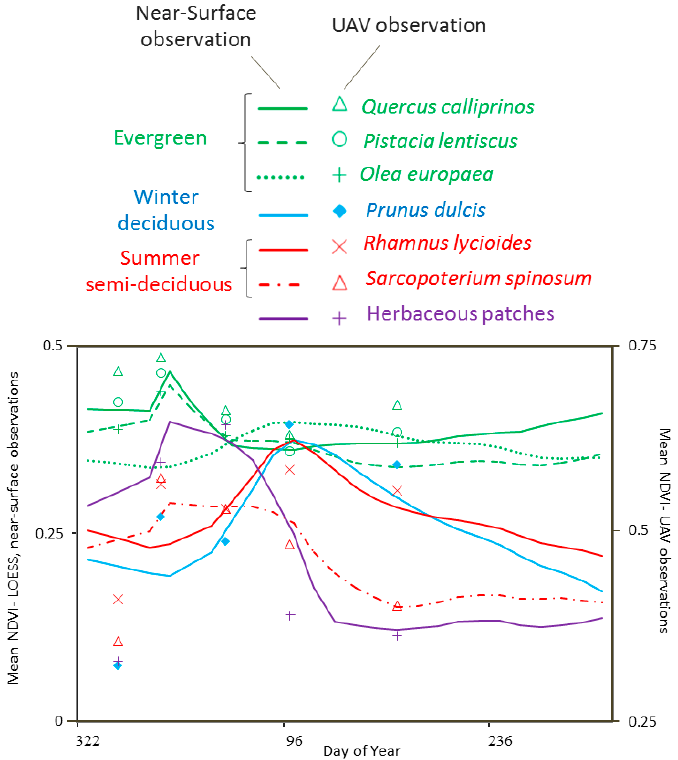
Figure 12. Mean NDVI time series of the near-surface and UAV observations for seven species that were classified in the Mata (M) site. The time series presents two following periods—LOESS of the preliminary near-surface observations (26 dates, 18 November 2015 to 2 November 2016), and five UAV imagery acquisition dates during the following year (Table 3). The sample size of each presented species is displayed in Supplementary Table S3. Pinus halepensis is not presented here because it was not included in the final near-surface dataset.